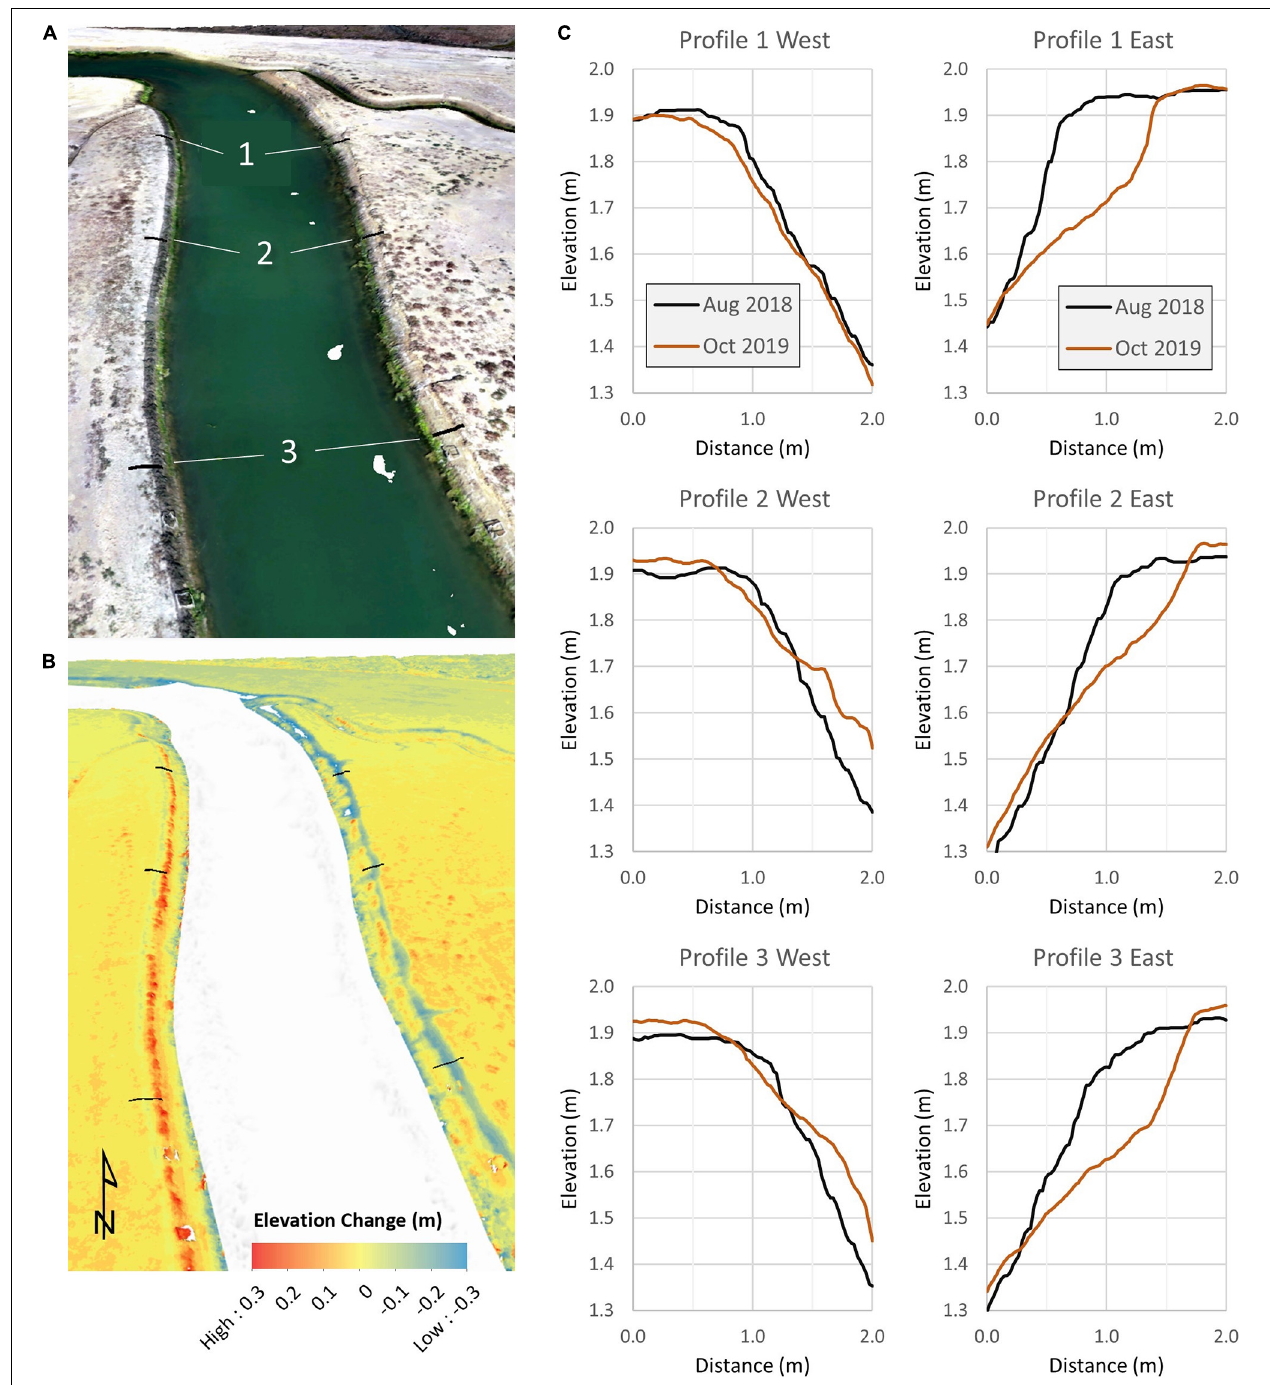
FIGURE 9 | A portion of the Hester Marsh main channel shown in (A) an October 2019 orthomosaic, and (B) a DoD between August 2018 and October 2019. The west bank of the channel was reinforced with mud excavated from the former wetland; the east bank had no reinforcement. (C) Vertical profiles extracted from UAV DEMs were used to evaluate erosion of the main channel banks between August 2018 and October 2019.